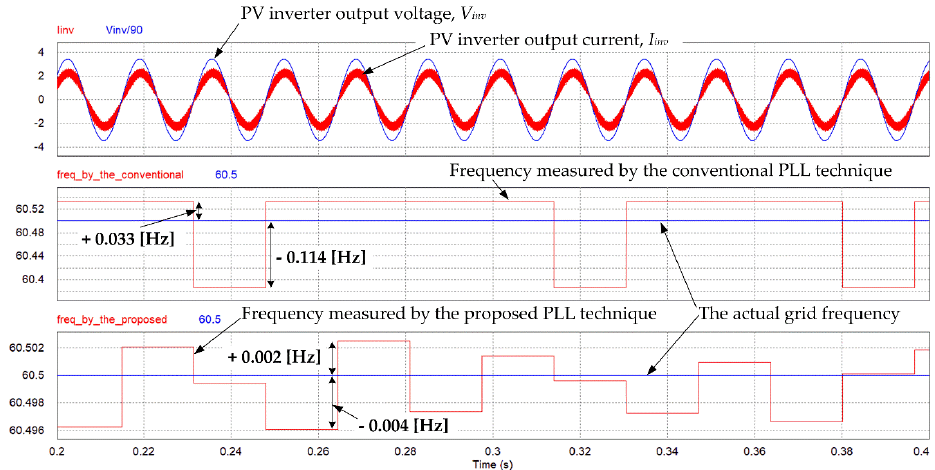
Figure 8. Key waveforms of the PV inverter when the grid voltage frequency is 60 Hz.